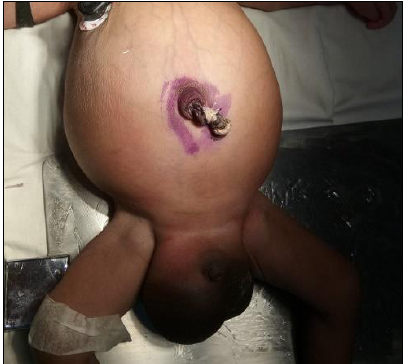
Figure 1: Abdominal distension and large scrotal swelling. A 4-day-old male baby presented with large scrotal swelling and abdominal distension since birth (Fig.1). Antenatal period was uneventful. Earlier he was misdiagnosed as obstructed inguinal hernia on sonography. Careful examination showed abdominal distension with scrotal swelling. Scrotal swelling was reducible. Baby had passed meconium with no vomiting. Hematological examination was normal. X- ray abdomen erect posture showed paucity of gas